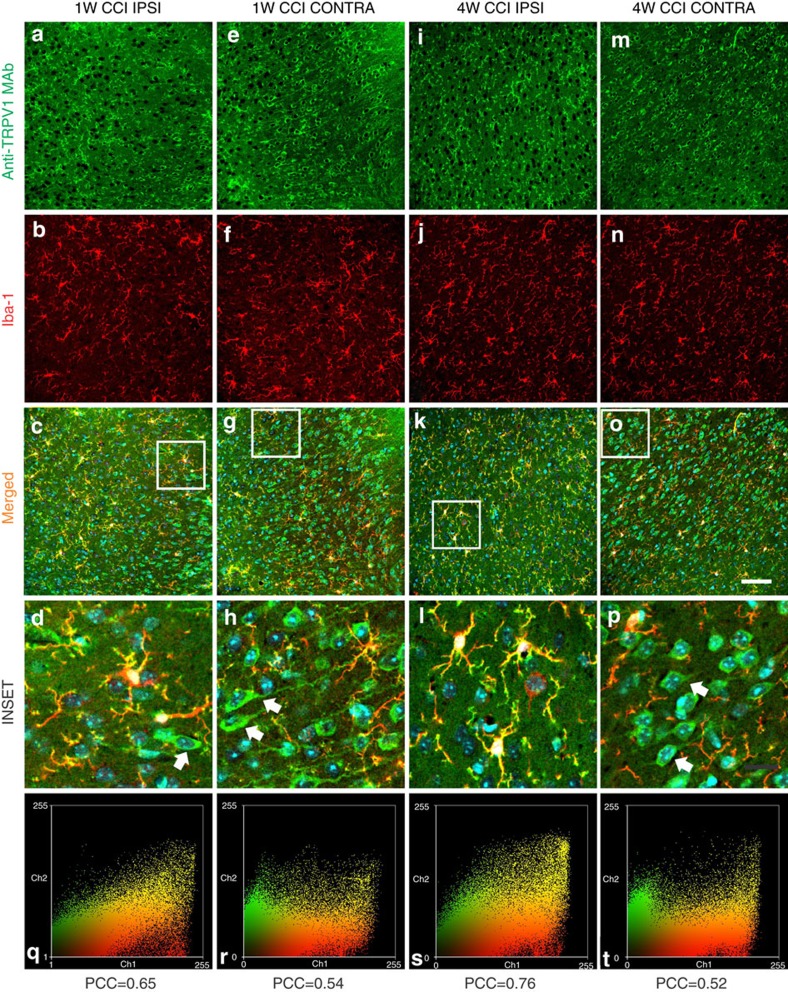
TRPV1 distribution pattern in the ACC of CCI adult mice.Beyond microglia cells (iba-1 positive, in red), the anti-TRPV1 MAb stains both the cytoplasm and apical processes of some iba1 immunonegative cells (white arrows in the INSET). This expression pattern was minor in the superficial cortical layers of the ipsilateral (IPSI; a–d) than contralateral (CONTRA, e–h) hemisphere of mice that underwent surgery from 1 week (1 W CCI mice). In 4-week CCI mice (i–l, m–p), when the chronicization of pain becomes established, the anti-TRPV1 MAb labels both cytoplasm and apical processes of iba1 negative cells (green) of the CONTRA hemisphere (o,p). Note that this staining pattern is also present in the deeper layers of the ACC (o) while is absent in the IPSI hemisphere of 4 W CCI mice (k,l). (INSET) High-power views of cells from the box areas in all merged panels. (q–t) Colour scatter plots representing the amount of colocalization (yellow) between the anti-TRPV1 (green) and iba-1 (red) in each condition. Smaller PCC values denote a higher expression of TRPV1 in the cytoplasm of iba1-immunonegative cells.